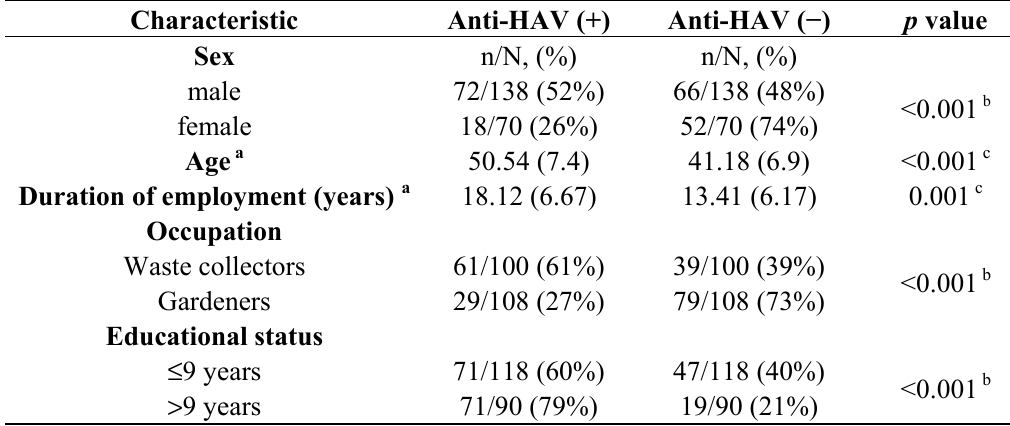
Table 2. Univariate analysis of Anti-HAV (+) among municipal workers.